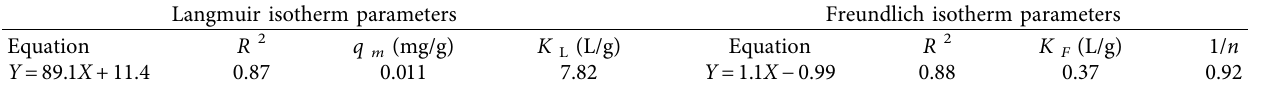
Table 5: Adsorption isotherm.